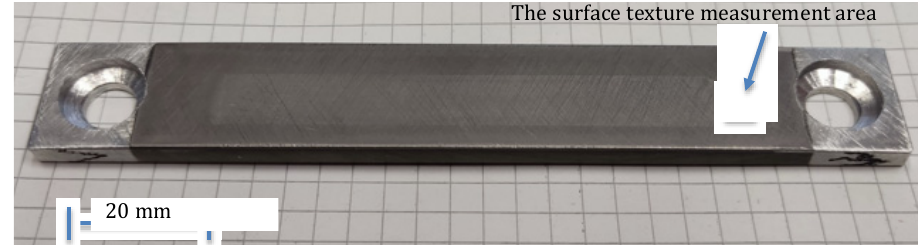
Figure 1. Example of B-type sample, with the ticking of the surface texture measurement area.